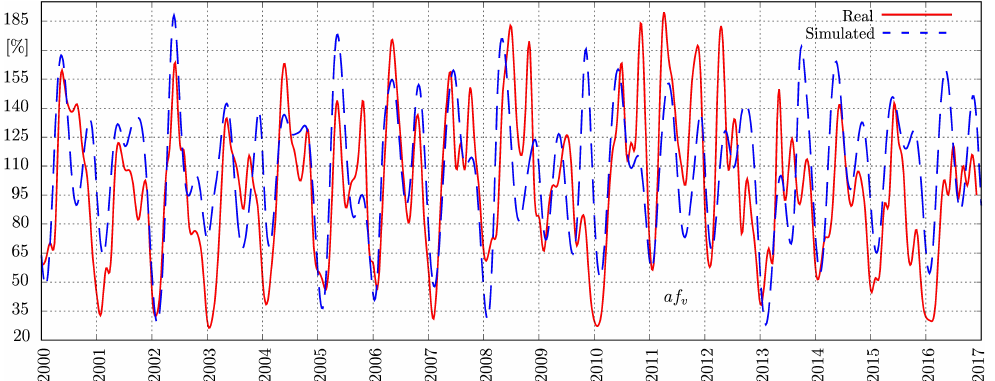
Figure 6. Availability factor of hydroelectricity generation ( af v ) [14], where the red line represents the real behavior of the series of aggregate flows of the Colombian rivers, obtained from [32], and the blue line was computed using Equation (2) and the Lorenz attractor (or Equation (1)), intended to represent the main characteristics of the real one (seasonality and ENSO phenomenon). MAPE = 11.35%. To model the a f v , the Lorenz chaotic attractor described in Equation (1) was then used to model the ENSO phenomenon, whereas the seasonality was represented by Equation (2). In general, the effects of seasonality are more pronounced when the ENSO appears, i.e., fur- ther decreasing water availability in dry seasons and increasing it during wet